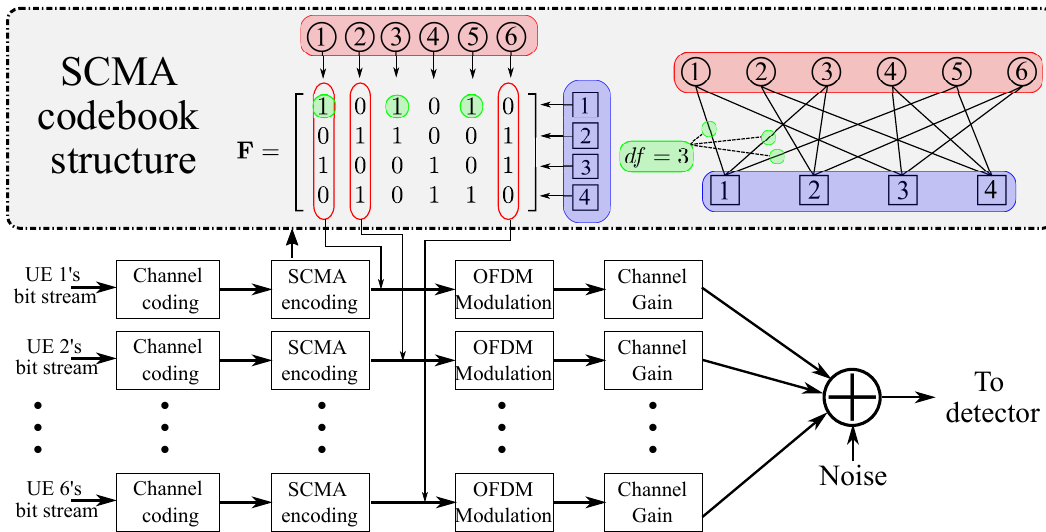
Figure 2. Example of an sparse code multiple access (SCMA) system with 6 active user equipments (UEs) and 4 orthogonal frequency division multiplexing (OFDM)